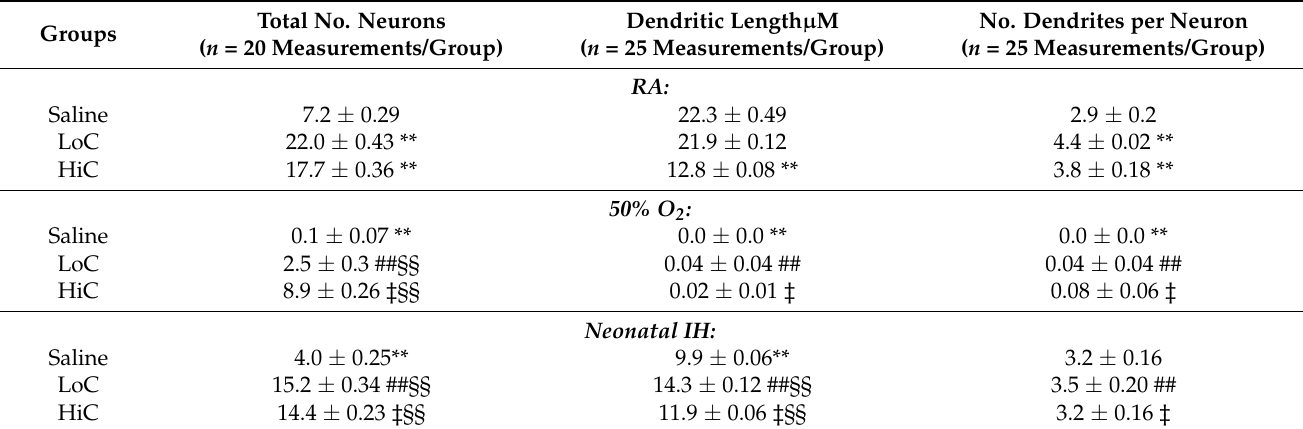
Table 3. Morphologic Parameters of Golgi